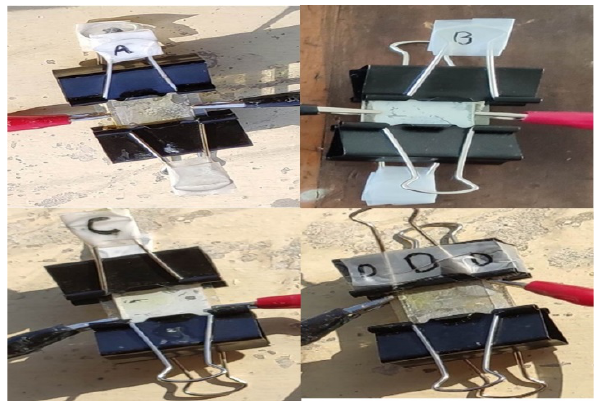
Figure 6. DSSC's Models ready for testing The experimental set up for calculations for all four samples and the equivalent circuit for the setup is shown in figure 7.